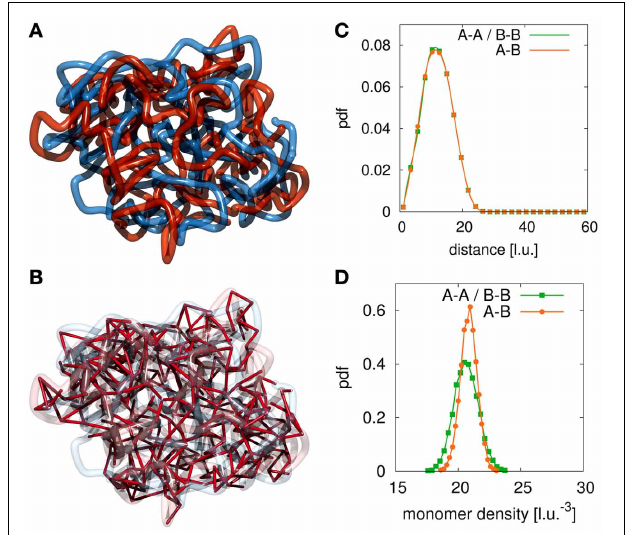
FIGURE 2 | Example conformation for completely intermingled sister chromatids. The red and blue strands each represent one sister chromatid and the red links visualize the interlinks between the two fibers. (A) For large numbers of interlinks the two sister chromatids are strongly intermingled due to the many tethering points. Such conformations resemble the situation after chromosome replication but before mitotic condensation has taken place. (B) In this image we highlight the interlinks between the two sister chromatids. We observe that the large number of interlinks leads to an strong intermingling of the two chromatids. Since links between the sister fibers are randomly established upon collision of fiber segments they can be found anywhere along the fibers. (C) In this panel we show the radial distribution function between segments of the two sister chromatids. In the case of completely intermingled chromatids, the correlation between polymers belonging to the same chromatin fiber (A-A, B-B) and the correlation between monomers from the two different chains (A-B) are exactly the same. (D) This panel shows the density distribution of other monomers surrounding each monomer. In the intermingled state, the distribution of monomers of the sister chromatid in the vicinity of a monomer is the same as the distribution of monomers of the own fiber around this monomer. It shows that the environment of each single monomer does not indicate its membership to either one of the chains.